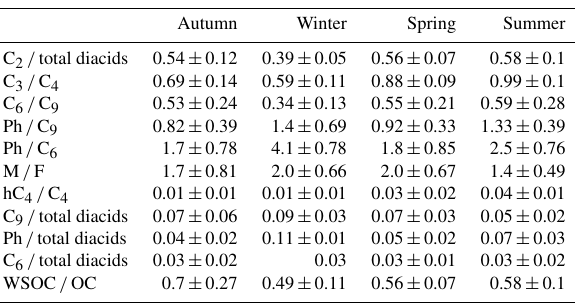
Table 3. Average seasonal variations in the ratios of diacids and related